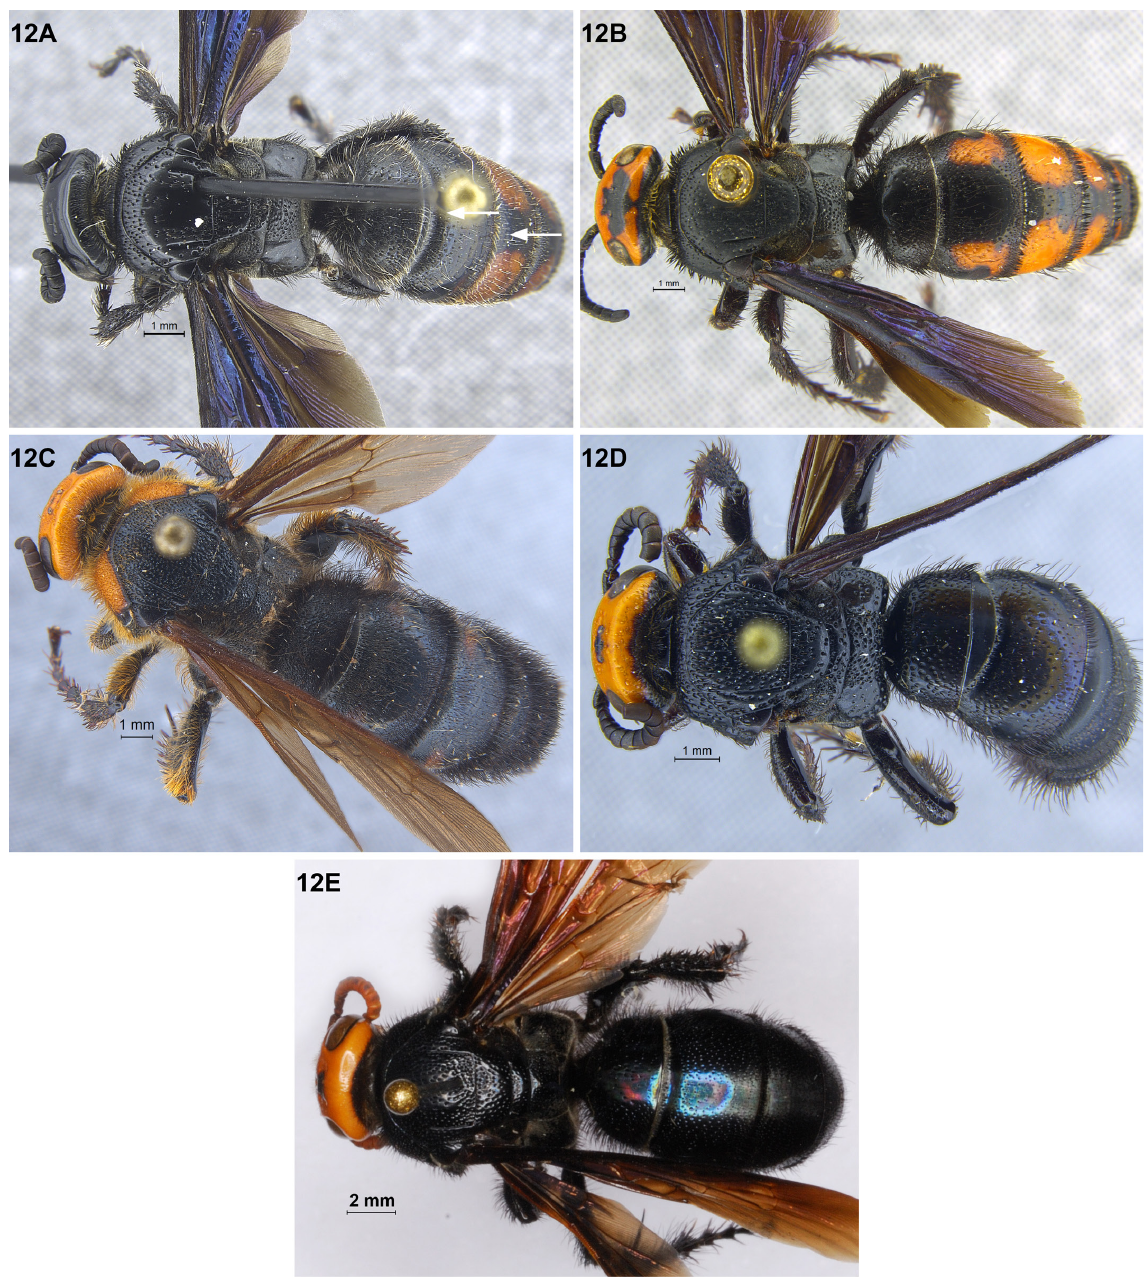
Fig. 12. Females, dorsal habitus. A . Scolia binotata Fabricius, 1804. B . Sc. binotata orange